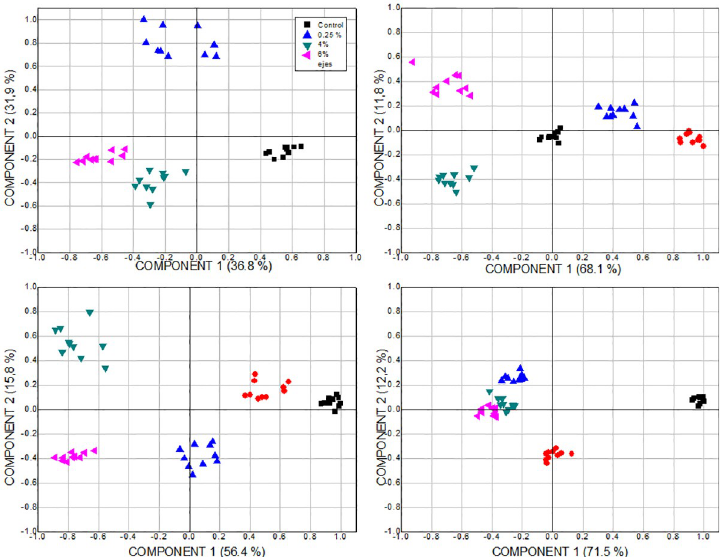
Fig 9. Plots of PCA scores considering the ROE of plants treated with Ag-TiO 2 NPs. NPs suspension of 0.25, 2, 4 and 6% concentration, of size a) 7.3 nm, b) 8.3 nm, c) 10.9 nm and d) 26 nm.